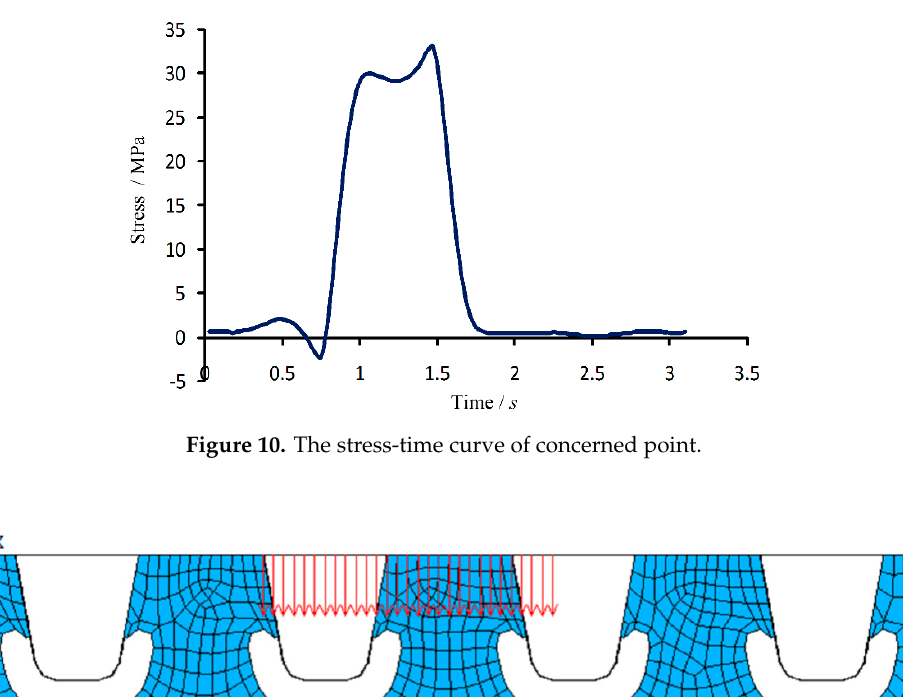
Figure 9. The position of the concerned point: ( a ) Position of the concerned point; and ( b ) the concerned point in the model.